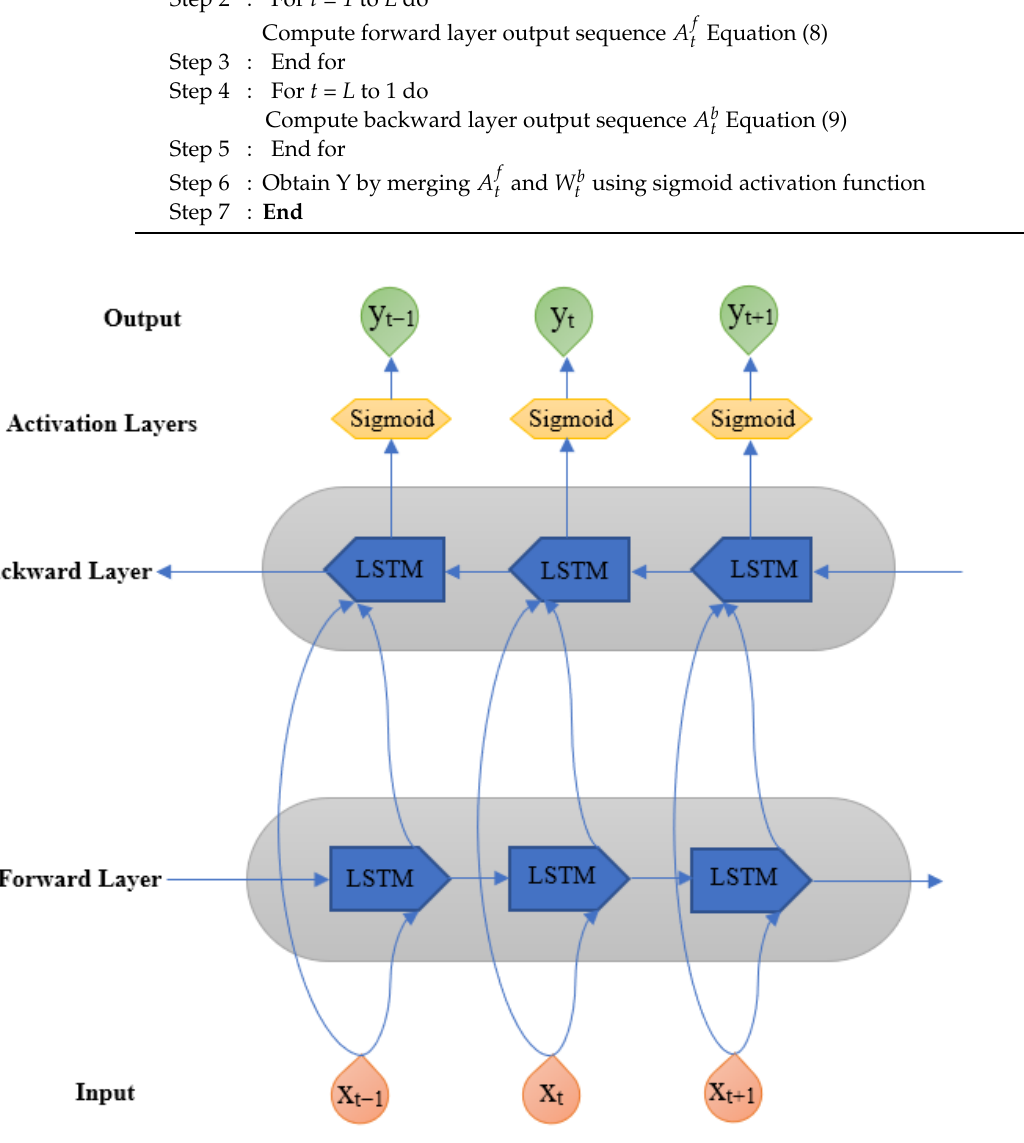
Figure 3. Detailed structure of the bidirectional long short-term memory (Bi-LSTM)